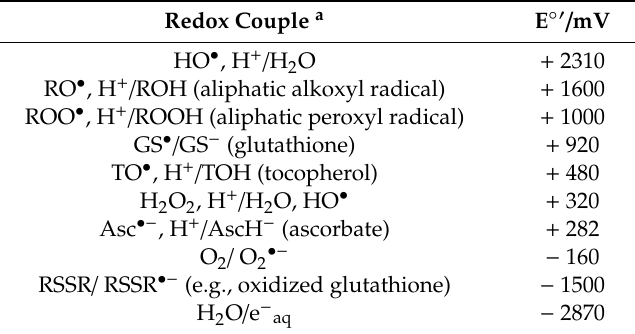
Table 1. Redox couple (one-electron reductions)